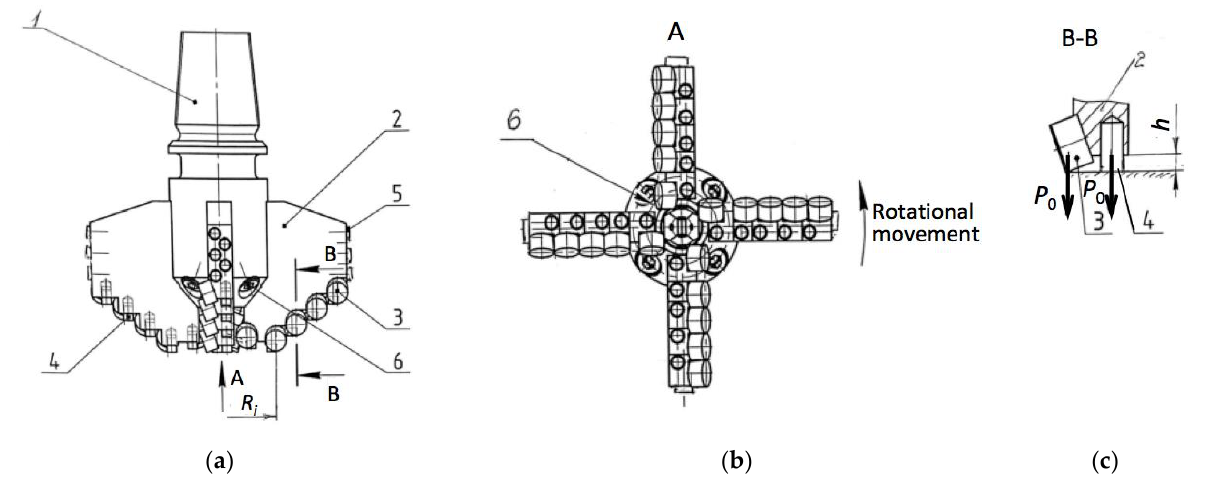
Figure 4. The modified bladed PDC design: ( a ) Side view; ( b ) View from the direction A; ( c ) View of the intersection B-B. Details are marked as follows: 1 — main body, 2 — blade, 3 — PDC cutter, 4 — pre-cutting insert, 5 — calibrating insert, 6 — hydromonitoring element.